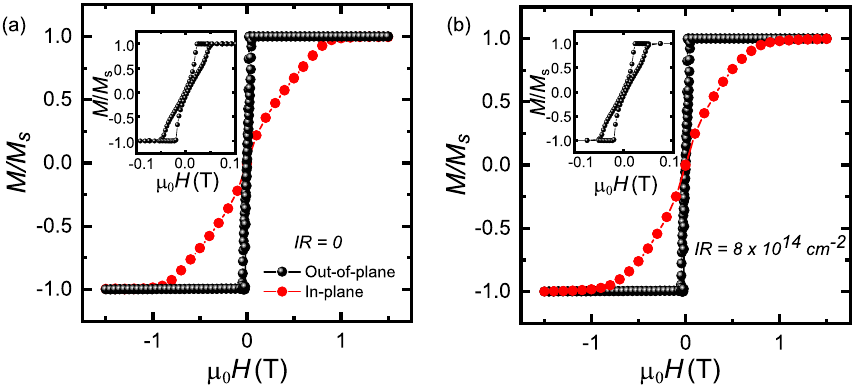
Figure 1. ( a , b ) Normalized magnetization measurements M / M s while sweeping the external magnetic field µ 0 H in the direction perpendicular (out-of-plane) and parallel (in-plane) to the multilayers with different IR at room temperature. Inset: Low field region for the out-of plane